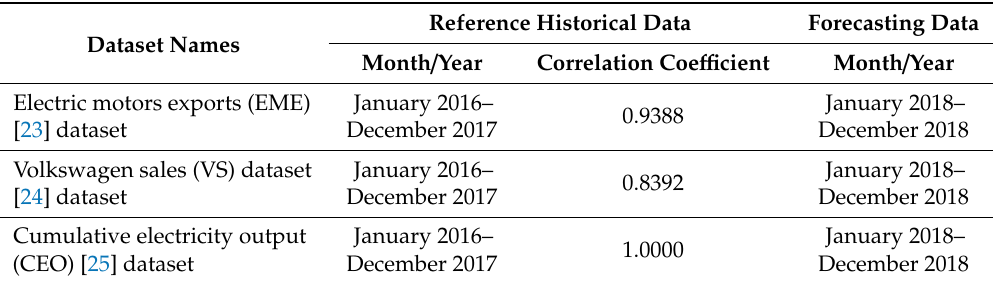
Table 1. Time series datasets used in the experiments.